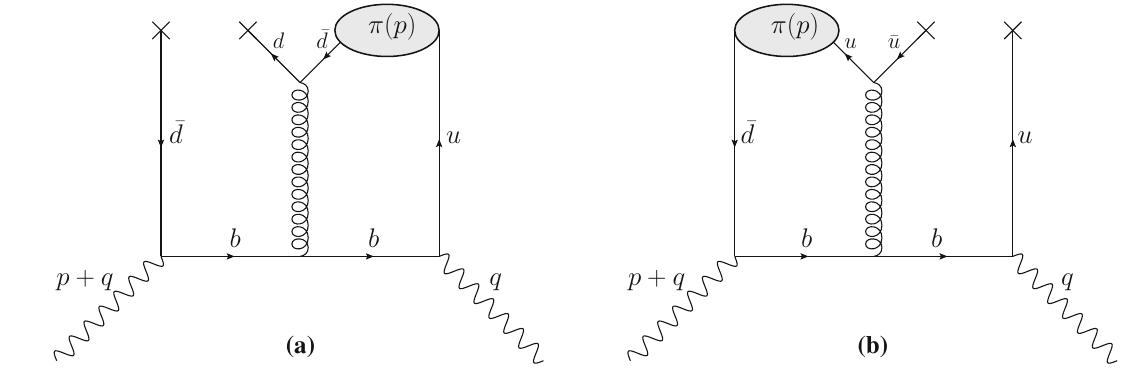
Fig. 1 Diagrams representing the factorizable twist-5 and twist-6 contributions to the correlation function (15)